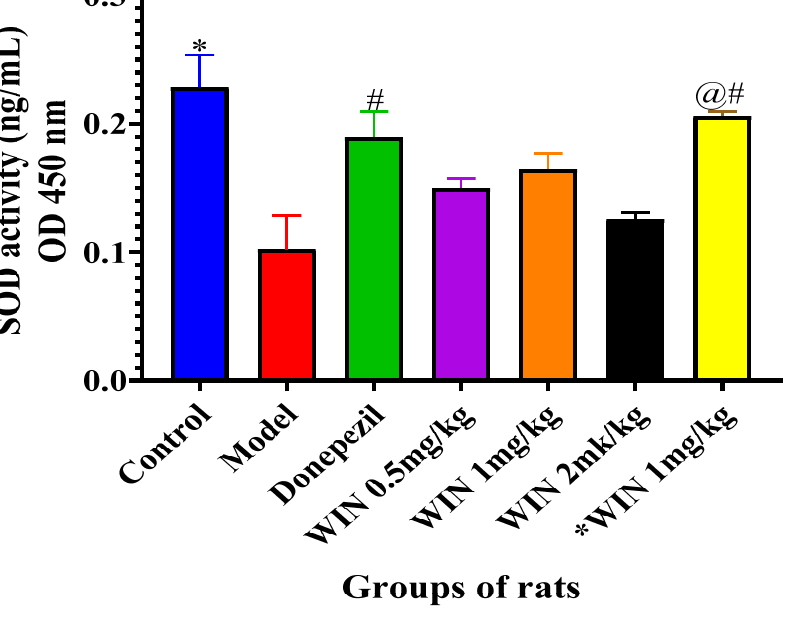
Figure 7. Effects of WIN on SOD activities in the brains of AlCl 3 − and D -gal-induced rats. Values are shown as mean ± SEM, n = 5. * p < 0.05 vs. model, # p < vs. control and @# p < vs. model.